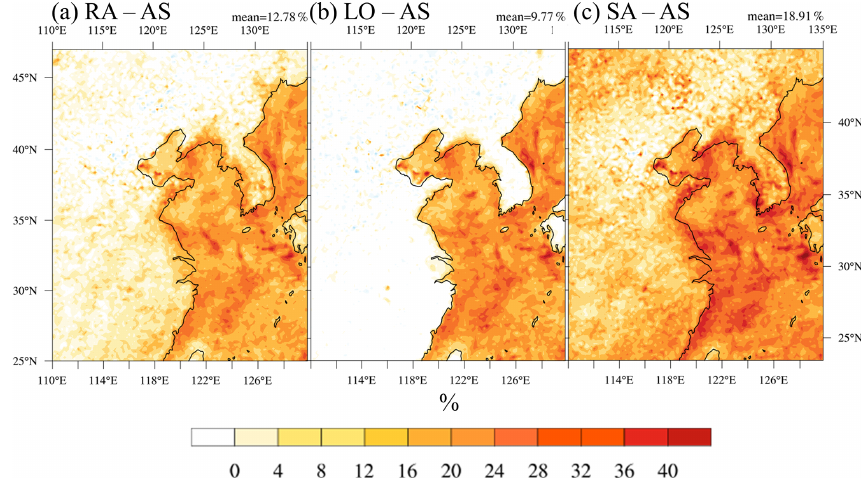
Figure 6. Same as Fig. 5 except for the cloud droplet number concentration (CDNC).